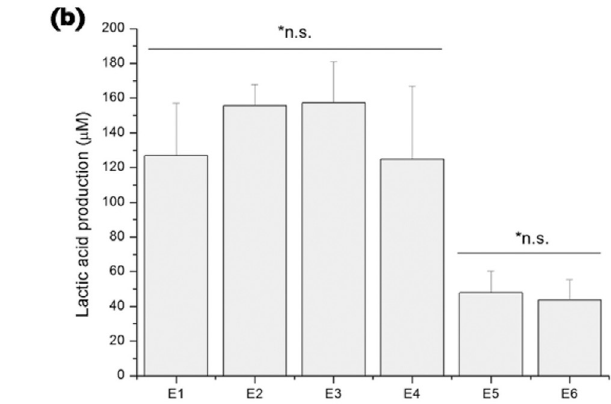
Figure 2- Size distribution of the ZnO-NP determined by NanoSight LM10 system. (a) image of the ZnO-NP dispersed in the test medium, and (b) histogram of the circle equivalent diameter (nm) of the ZnO-NP